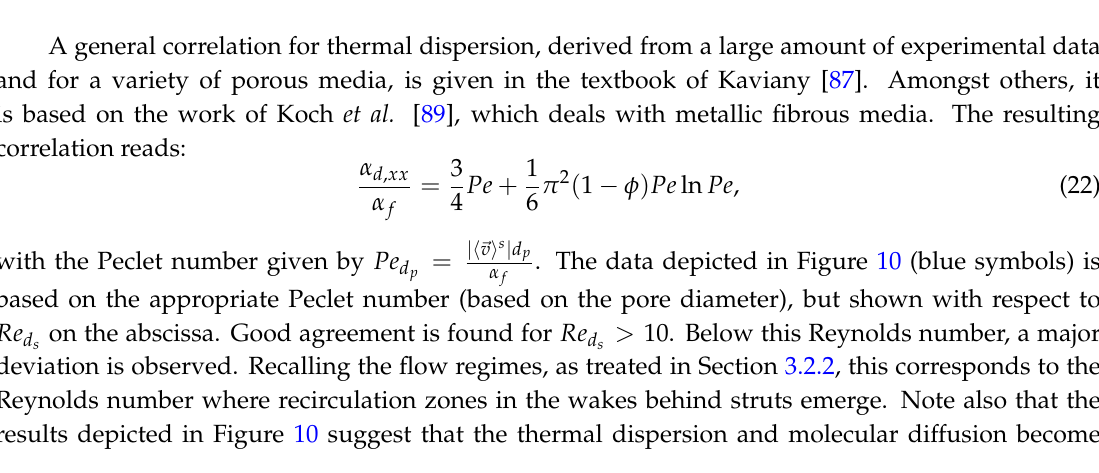
Figure 10. Validation of thermal dispersion diffusivity. The symbols + and ◦ represent respectively the k d , xx and k d , yy results. The colors distinguish between data from Calmidi et al. [38] (red), Kaviany [87] (blue), Steven et al. [88] (green) and the CFD results obtained in this work